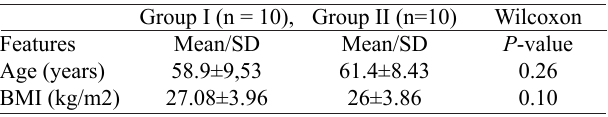
Table 1. Patient characteristics regarding age and BMI.